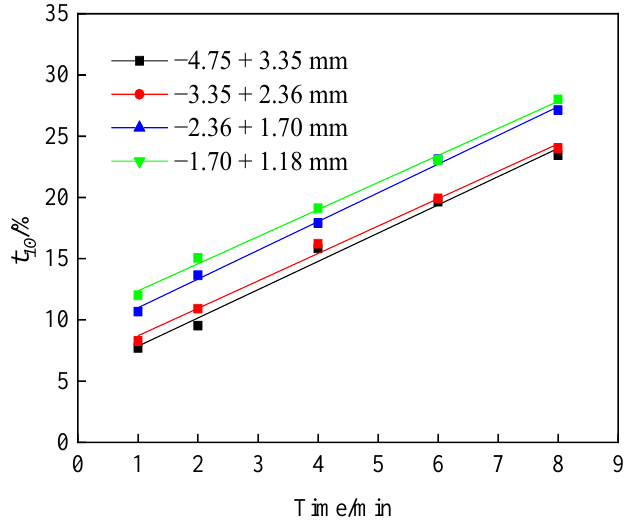
Figure 2. The relationship between grinding products t 10 and grinding time of polymetallic complex ore with different feed sizes.